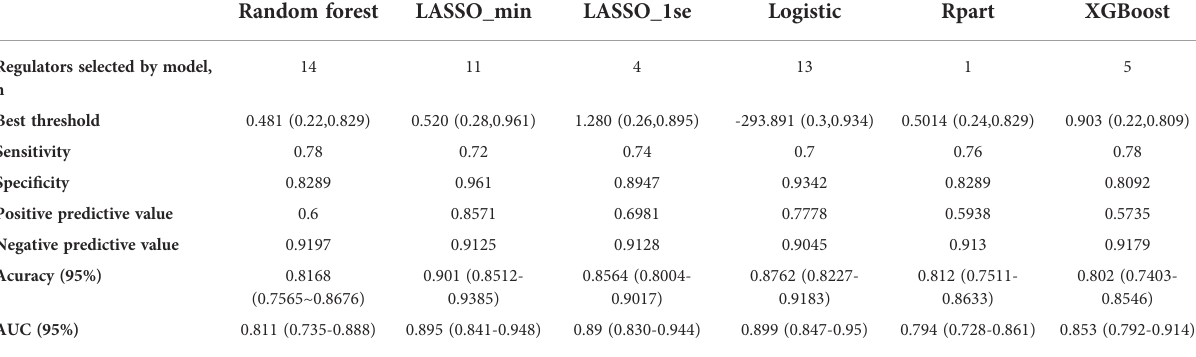
TABLE 1 Model performance of the six classi fi ers in validation set 1: A random forest wrapper (Boruta), LASSO_ l -min, LASSO_ l -1se, logistic regression, regression partition trees (Rpart) and extreme gradient boosting (XGBoost). Random forest LASSO_min LASSO_1se Logistic Rpart